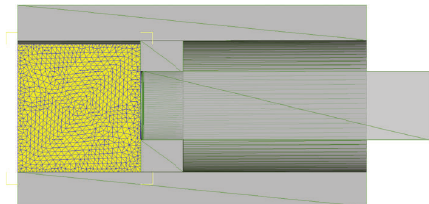
Figure 4: Diagram of heat transfer between billet and